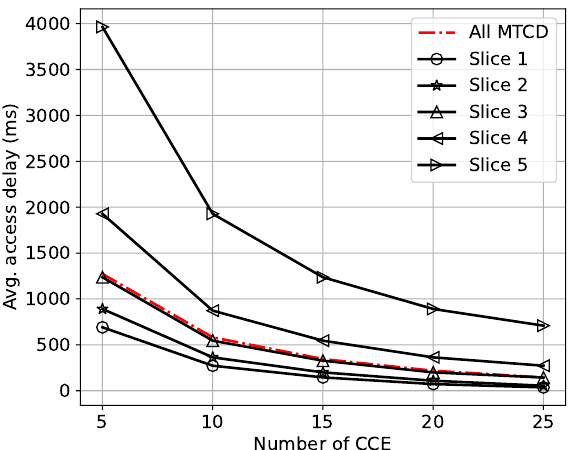
Figure 5. Average access delay vs. the number of available CCEs in